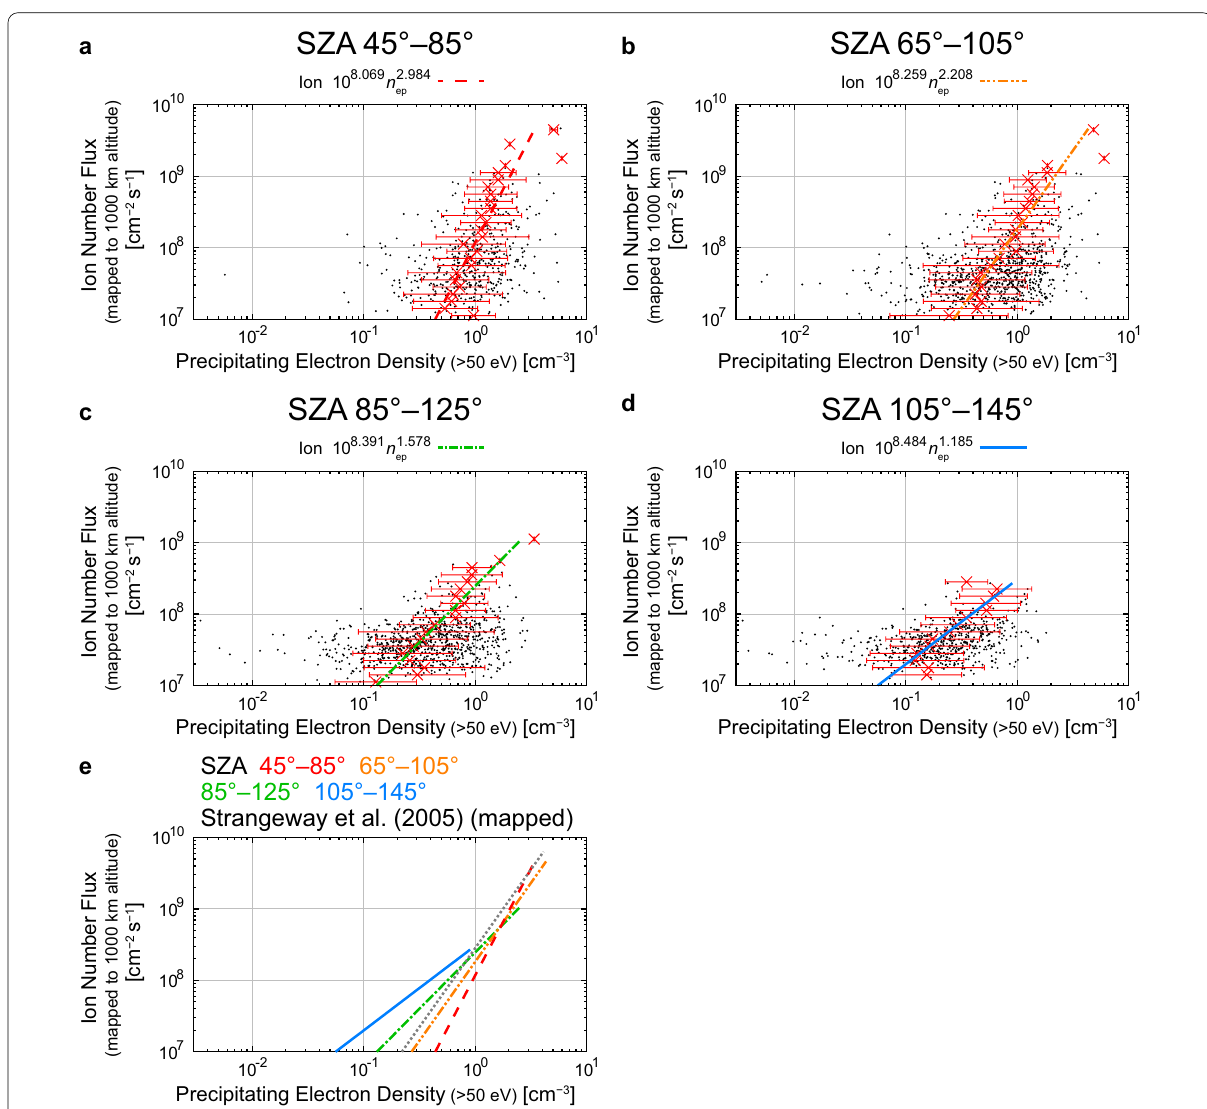
Fig. 4 Relations between the precipitating electron density (< 50 eV) and the mapped outflowing ion number flux in the SZA ranges of a 45°–85°, b 65°–105°, c 85°–125°, and d 105°–145°, and e comparisons among the derived empirical relations in these SZA ranges and the empirical formula derived by Strangeway et al. (2005) (their Eq. 3) (multiplied by a factor of 2.9 to correct for the altitudinal difference of the ion number flux and the precipitating electron density) (dotted gray line). The format is identical to that of Fig. 3. There are 3 data points below precipitating electron density of 3 10 − 3 cm − 3 . The precipitating electron densities and the mapped outflowing ion number fluxes of the 3 events are 8.39 × and 1.91 10 − 3 cm − 3 , and 5.76 10 7 , 1.93 10 7 , and 4.85 10 7 cm − 2 s − 1 at SZA of 94.7°, 99.8°, and 142.9°, × × × ×